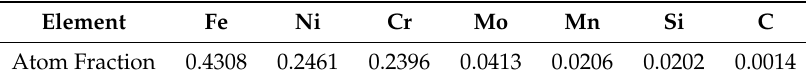
Table 1. Composition of